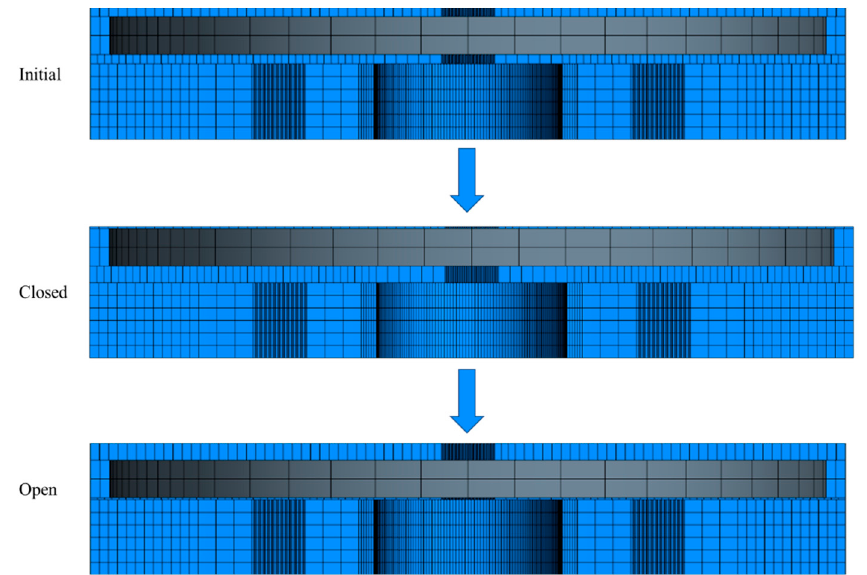
Figure 14. The mesh’s behavior in three different plate positions: at the initial stage, with the water inlet (closed position), and finally with the oil inlet (open position).